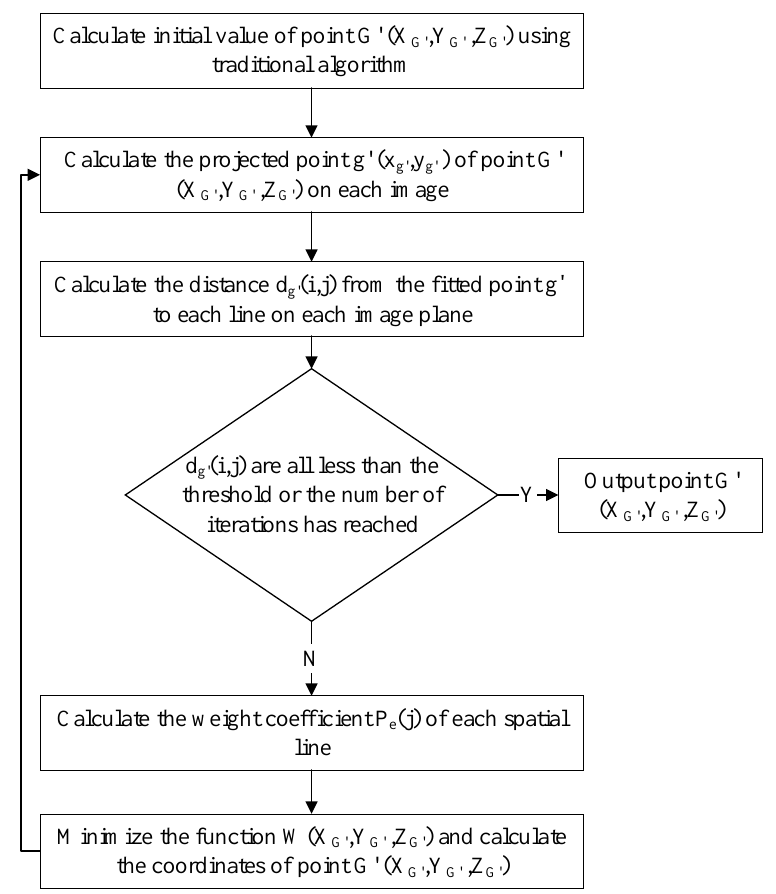
Figure 2. Iterative optimization calculation flow